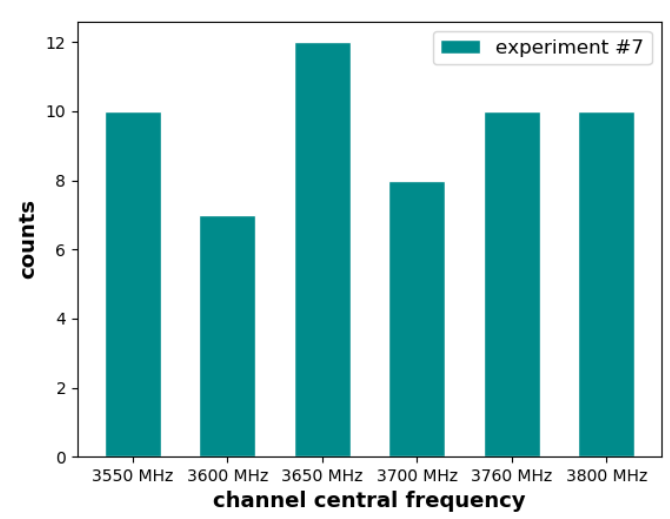
Figure 7. Channels utilized for transmissions in a 8-node full-mesh topology in ORBIT.